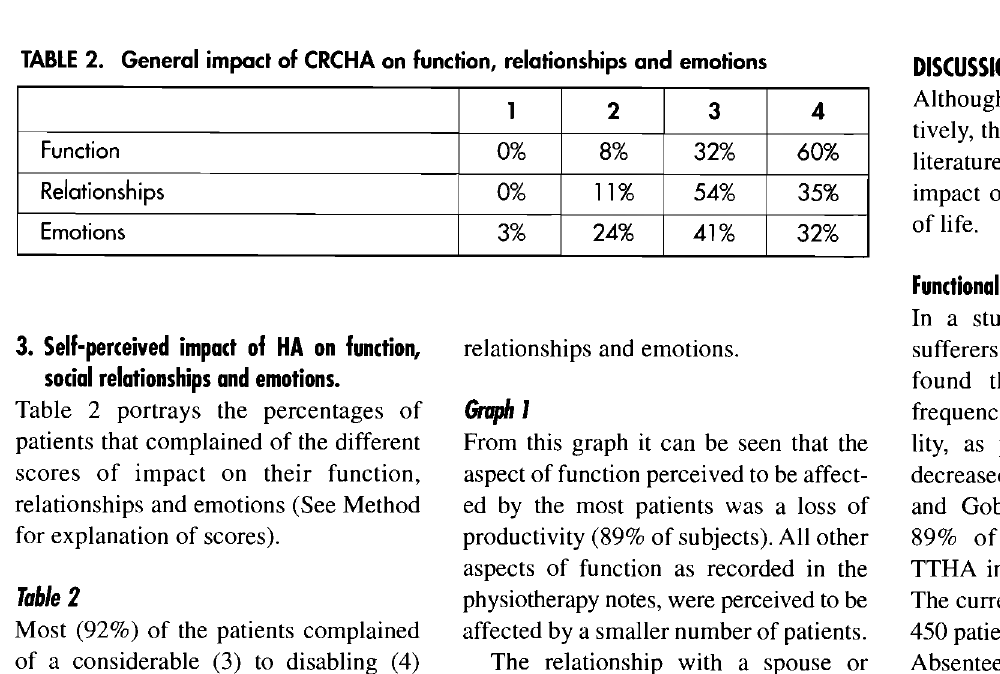
TABLE 2. General impact of CRCHA on function, relationships and emotions 1 2 3 4 Function Relationships 0% Emotions 32%